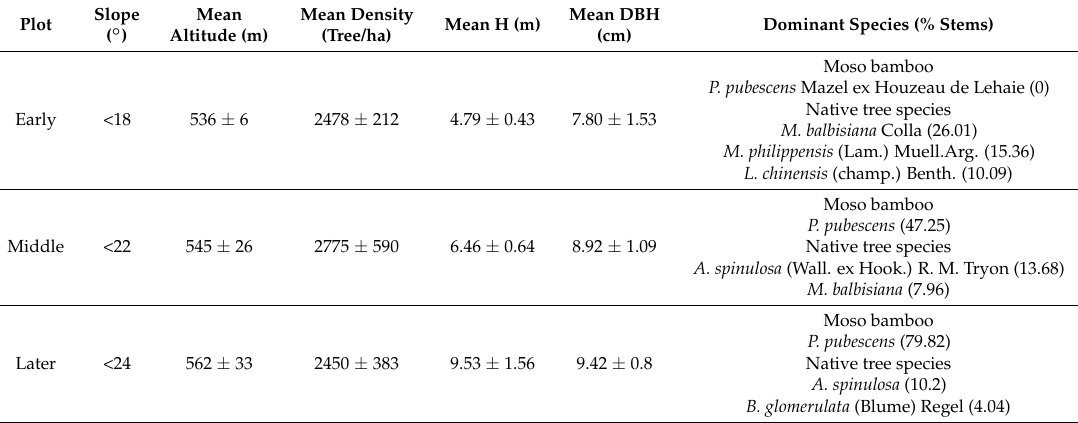
Table 1. Stand characteristics of all the plots. Three most dominant species in each of the plots (values presented are means ± standard deviation in replicated plot level). DBH: diameter at breast